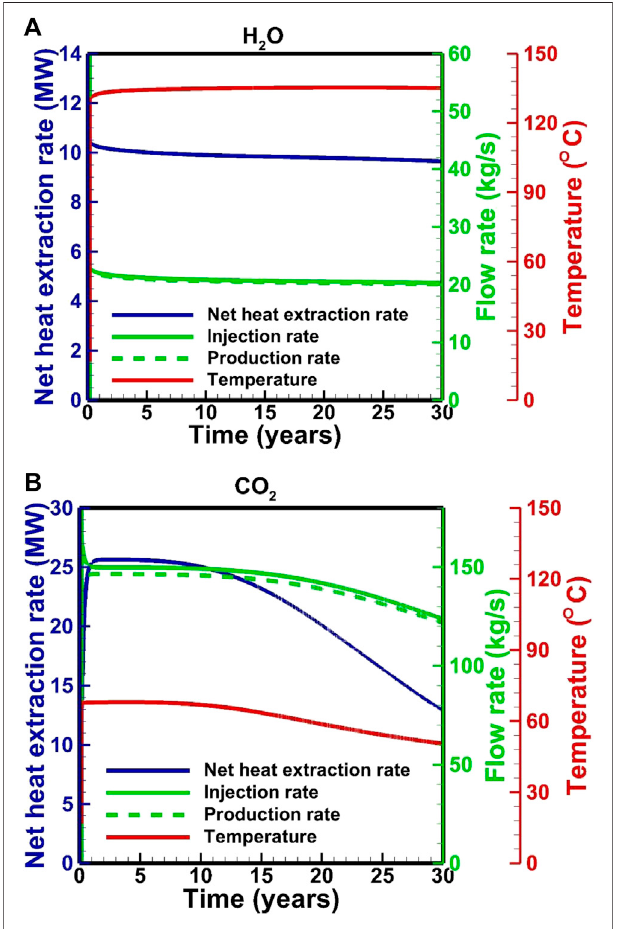
FIGURE3| Keyperformanceparametersfor (A) theH 2 O-basedand (B) CO 2 -based EGS from simulations.